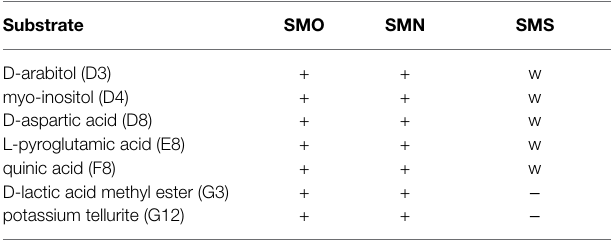
TABLE 2 | Biochemical characteristics of three Stenotrophomonas maltophilia samples.